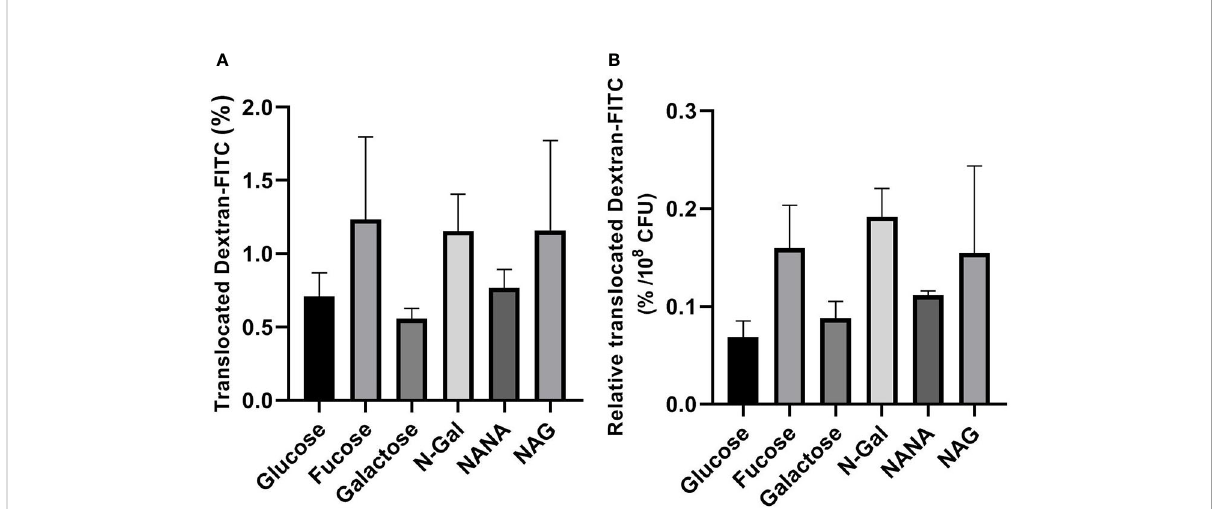
FIGURE 6 Dextran-FITC translocation across HCT-8 monolayers. E. coli O157:H7 D stx2 + 100 ng/ml Stx2 cultures were coincubated with HCT-8 monolayers grown on Milicell supports with M9 medium supplemented with 10 mM mucus-derived metabolites (Fucose, Galactose, N-Gal. NANA or NAG) or Glucose at 37°C for 5 h in a humidi fi ed 5% CO 2 incubator. (A) Percentage translocated Dextran-FITC (basal chamber) calculated as fl uorescence measured in the basal chamber/total fl uorescence*100. (B) Percentage translocated Dextran-FITC (basal chamber) relative to bacterial density found in the apical chamber after treatments, expressed as percentage of translocated Dextran-FITC per 10 8 CFU. Data shown as mean ± SEM. No signi fi cant differences were found between treatments (p > 0.05, n =